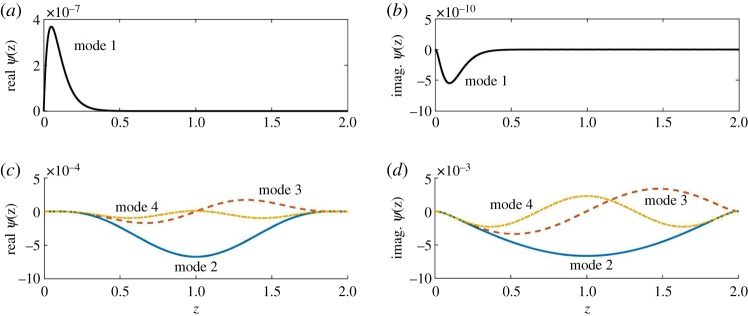
Eigenfunctions ψ(z) corresponding to the top four eigenvalues with the largest real parts. Panels (a,b) indicate that the eigenfunction corresponding to the first mode has a localized structure near the bed (z = 0). The other modes appear symmetric and span the thickness of the film. k = 20, θ = 0.01, Re = 20, L = 10−3, α = 10−3. The structure of the first mode becomes more localized as k increases. The large value of k is chosen to visually highlight the localized structure. The first mode ψ (a) real part and (b) imaginary part. (c) The next three modes (real parts). (d) The next three modes (imaginary parts). (Online version in colour.)